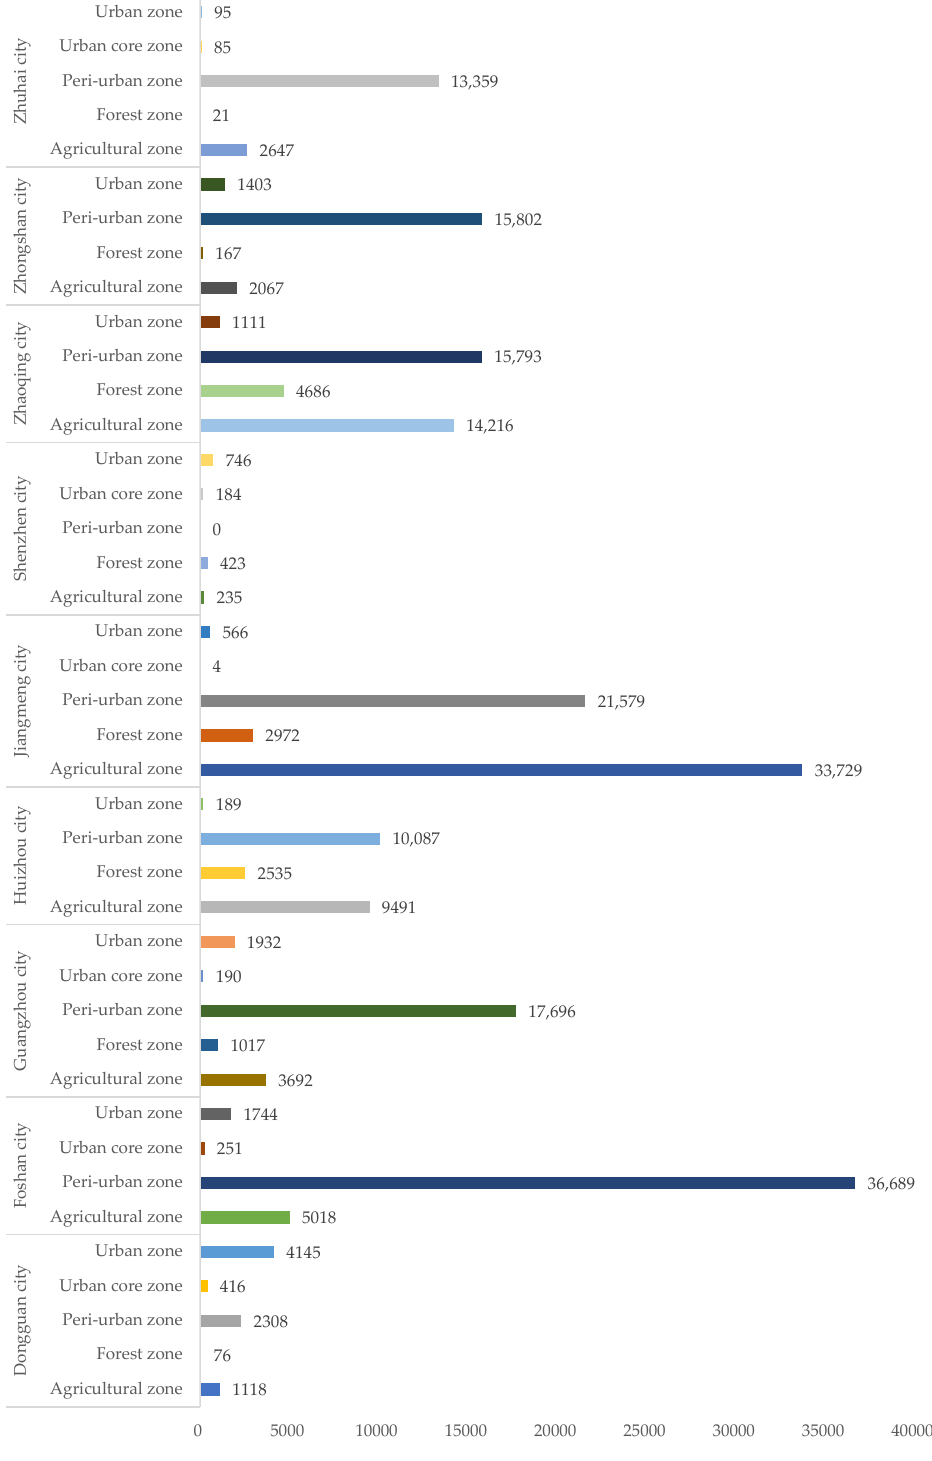
Figure 7. Total area of pond landscape patches (CA) along an urban-rural gradient of nine cities in the PRD.